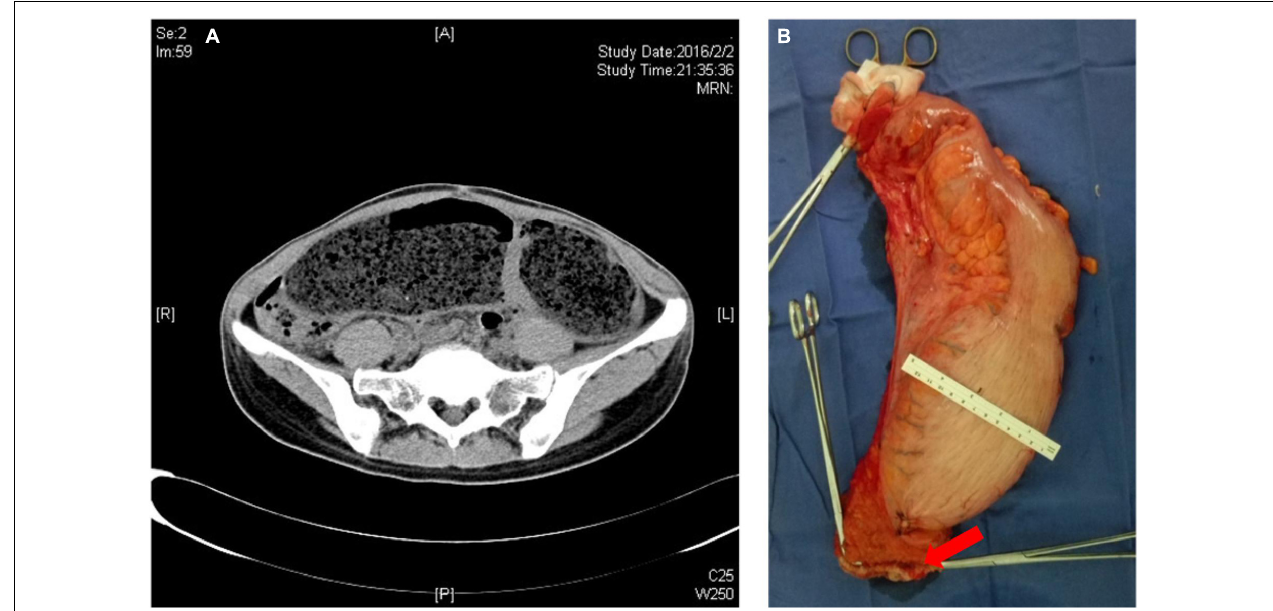
FIGURE 1 | (A) CT image of adult congenital megacolon; (B) resected specimen of adult congenital megacolon (red arrow: the stump of the